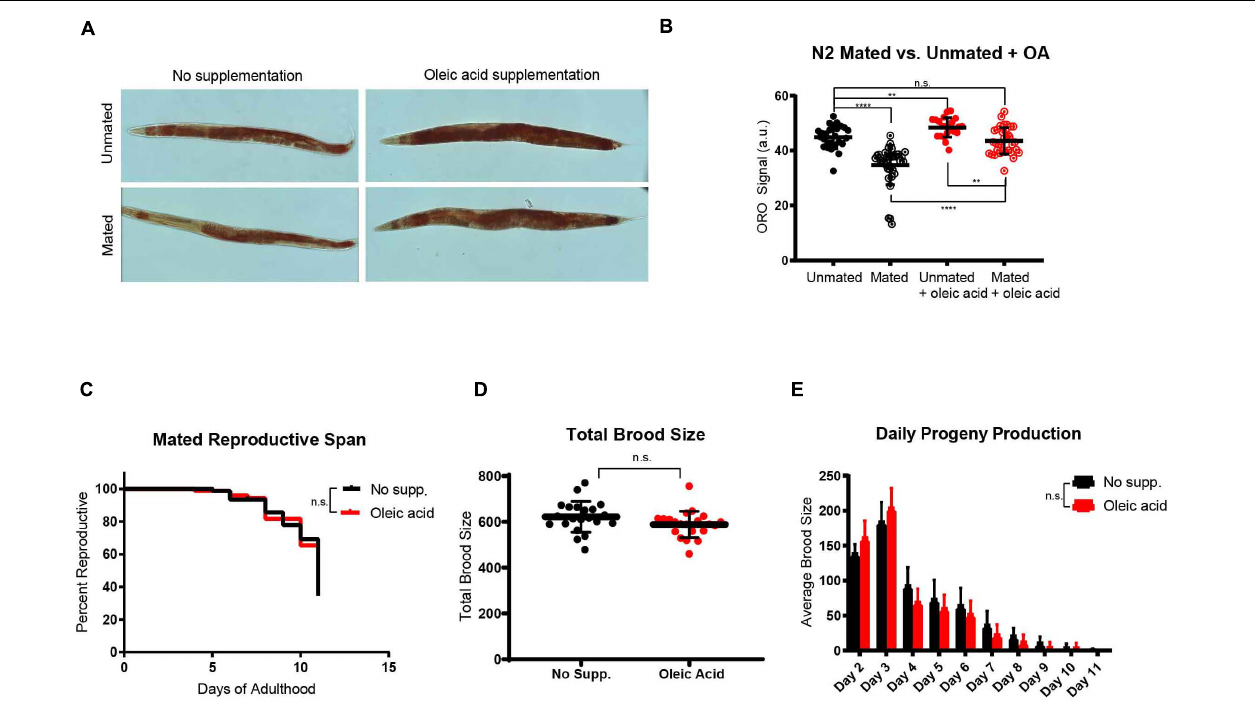
FIGURE 3 | Oleic acid supplementation restores fat storage without changing the reproduction of C. elegans mothers. (A) Dietary supplementation of oleic acid restores overall fat storage in wild-type hermaphrodites. Representative pictures of Oil red O fat staining are shown. (B) Quantification of Oil red O fat staining. Error bars: SD. t -test, ** p < 0.01, **** p < 0.0001, n.s., not significant. (C) The reproductive span of mated worms is not affected by oleic acid supplementation. (D) The total brood size of mated worms is not affected by oleic acid supplementation. (E) Daily progeny productions of mated worms with and without oleic acid supplementation are not statistically